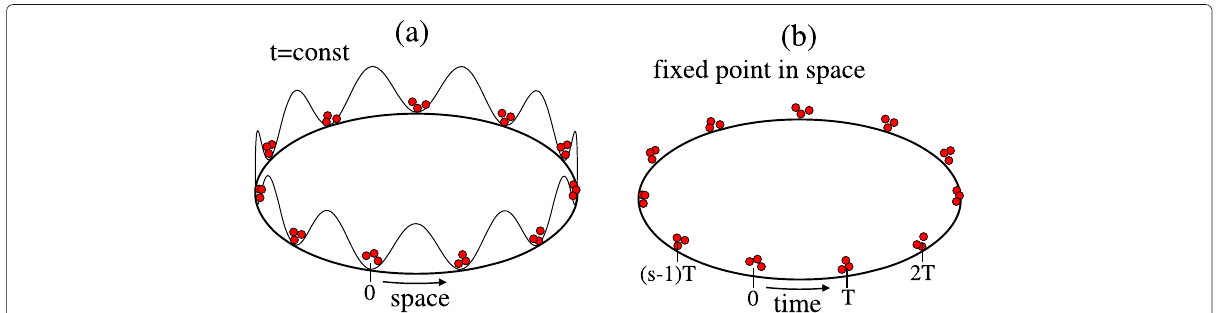
Fig. 6 a Schematic plot of the Mott insulator phase in a 1D space crystal with periodic boundary conditions. b Similar Mott insulator phase but in the time domain. In order to switch from space to time crystals, one has to exchange the role of space and time. That is, the position in space is fixed and we analyze how the probability of detection of particles at this fixed point changes in time. In the Mott insulator phase, a well defined number of atoms are appearing at this fixed point like on a conveyor belt or in a machine gun. Reprinted from [41] a Bose-Einstein condensate. The superfluid-Mott insula-